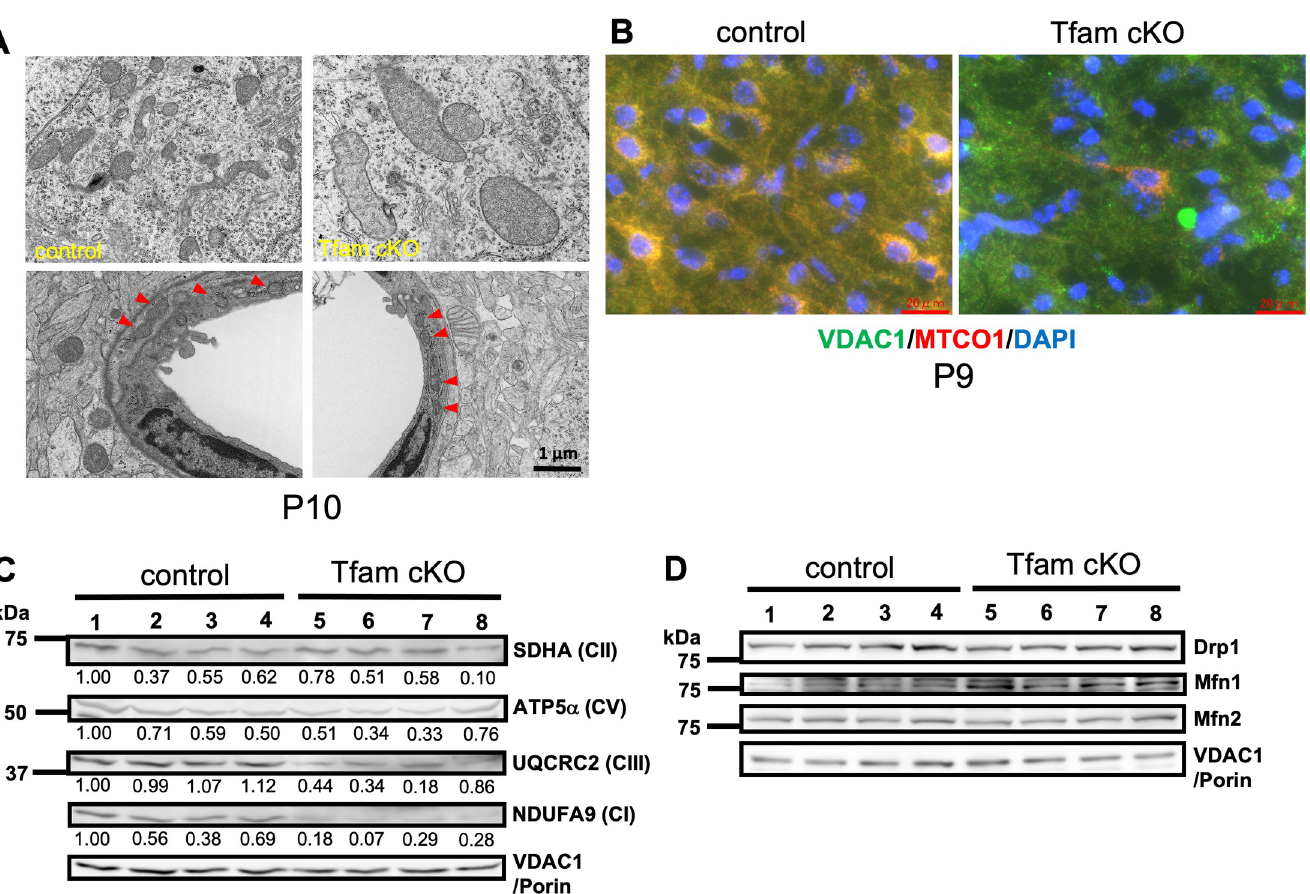
Fig 4. Mitochondrial defects in Tfam cKO mouse brains. (A) Ultrastructural analysis of mitochondria by transmission electron microscopy (TEM). Representative TEM images of brain sections from control and Tfam cKO at P10. In Tfam cKO brains, mitochondria in pyramidal cells in layer V shown in the upper panels are swollen and enlarged. On the other hand, mitochondria in endothelial cells (indicated by arrowheads) shown in the lower panels appear normal. At least two independent brains per genotype were examined. Scale bar, 1 μ m. (B) Immunofluorescence of VDAC1/Porin and MTCO1 with DAPI nuclear staining for pyramidal cells in layer V at P9. Scale bars, 20 μ m. (C) Western blot analysis of protein levels in brains from Tfam cKO and control at P8. Samples were probed with antibodies against SDHA, ATP5 α , UQCRC2, NDUFA9, and VDAC1/Porin. (D) Western blot analysis of protein levels of mitochondrial fission and fusion related proteins in brains from Tfam cKO and control at P8. Samples were probed with antibodies against Drp1, Mfn1, Mfn2, and VDAC1/Porin.